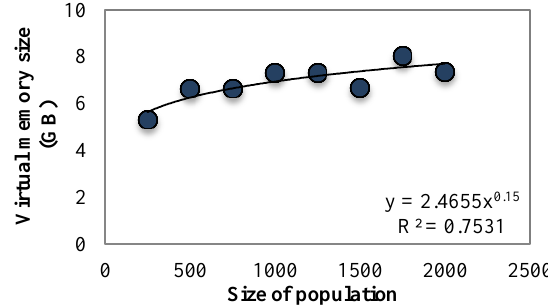
Figure 14. Size of population versus average virtual memory size (GB).